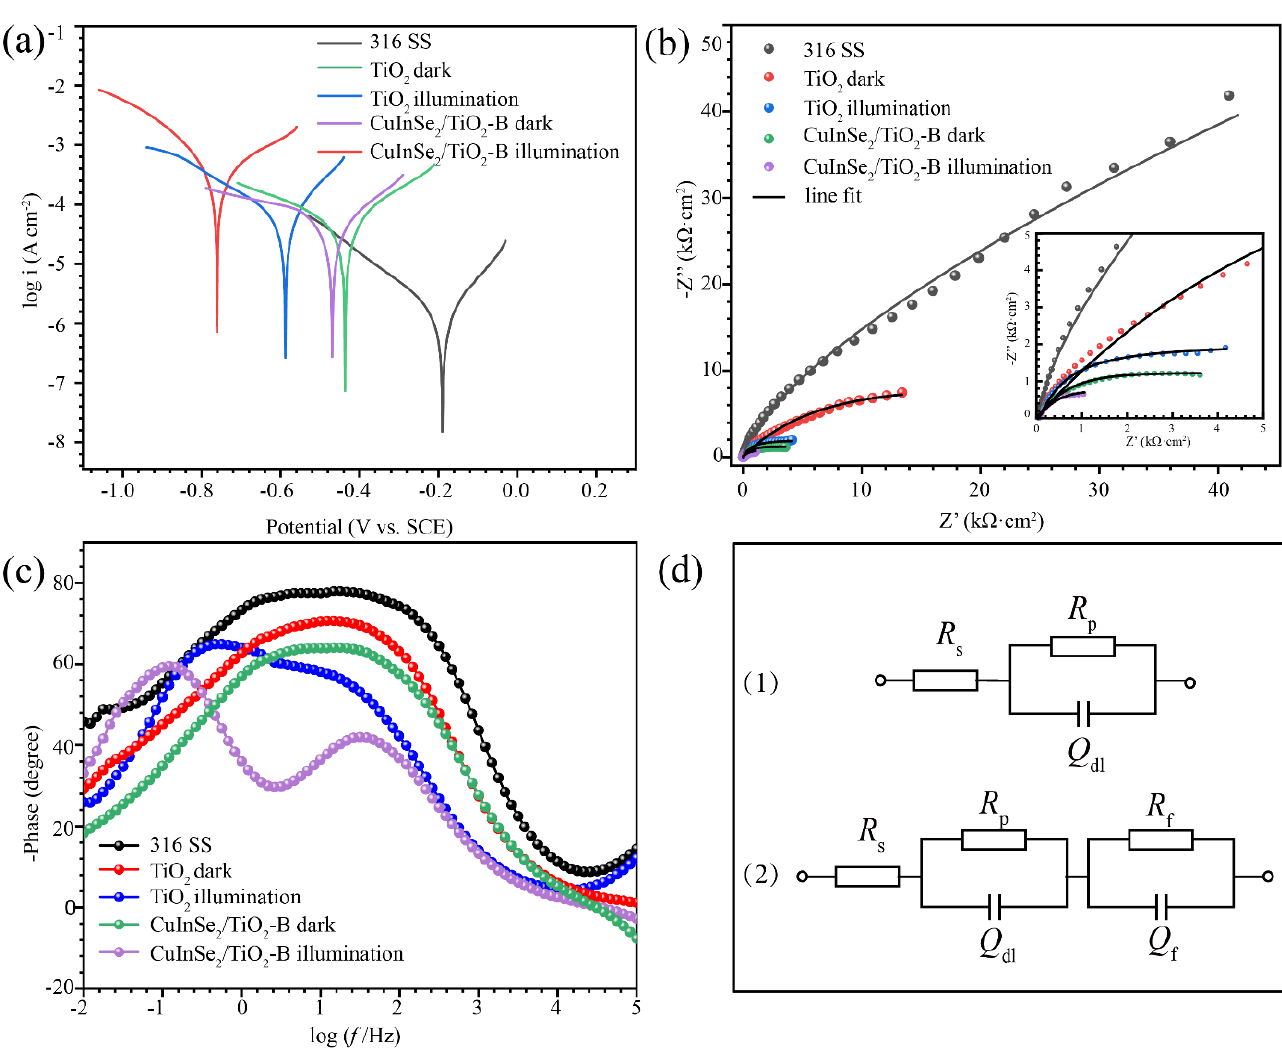
Figure 7. ( a ) Tafel curves, ( b ) Nyquist plots, and ( c ) Bode ‐ phase curves of pure 316 SS and 316 SS coupled with different photoanodes under intermittent visible light; ( d ) the equivalent circuit for fitting the impedance data.